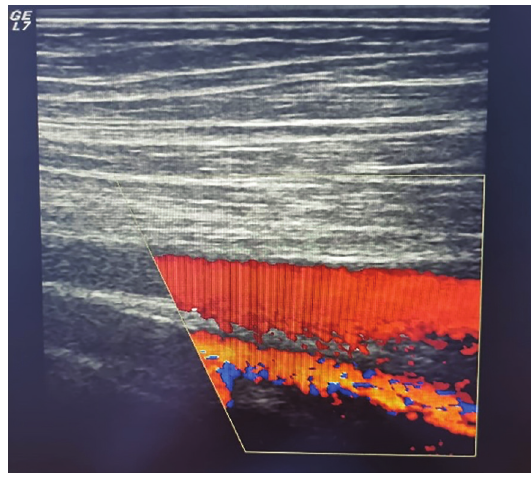
Figure 1 - Ultrasound signs of the absence of thrombosis: complete staining of vein on color flow